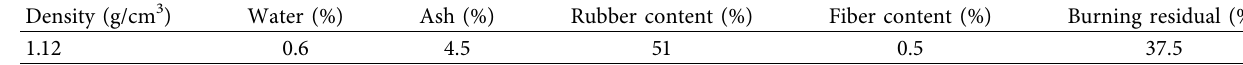
Table 2: Main technical indexes of CR.